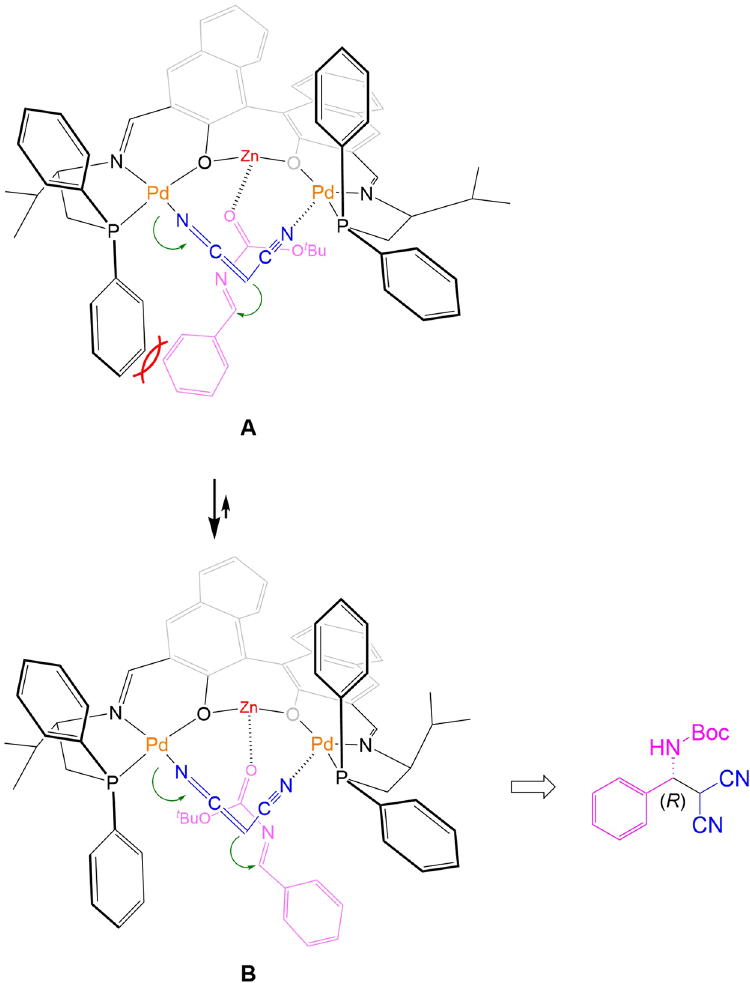
Figure 6. Plausible reaction model for asymmetric Mannich reaction using L1 -Pd 2